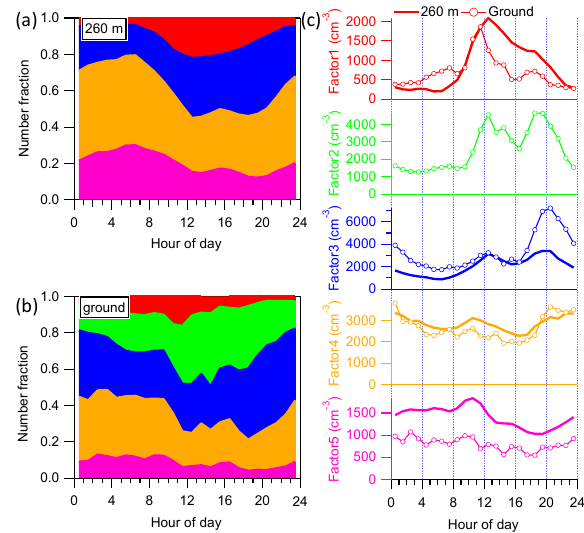
Figure 10. Average diurnal variations in number fraction of PMF factors at (a) ground level and (b) 260m. Panel (c) shows a compar- ison of the average diurnal cycles of particle number concentrations for PMF factors at ground level and